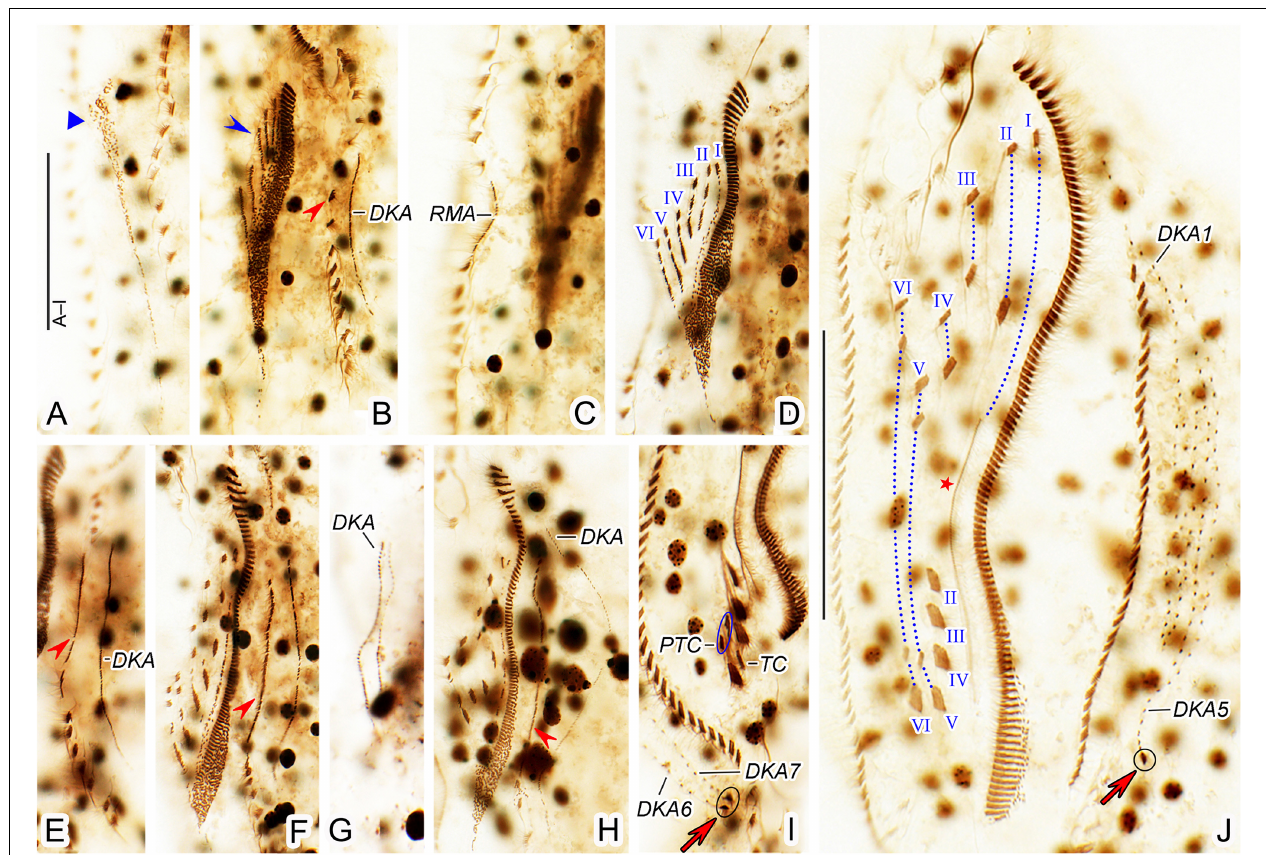
FIGURE 5 | Trachelostyla multinucleata spec. nov., early (A–C) , middle (D–H), and late (I,J) stages of physiological reorganization after protargol impregnation. (A–C) Ventral views to show the formation of the oral primordium (blue triangle), frontal-ventral-transverse cirral anlagen (blue arrowhead), left (red arrowhead) and right marginal cirral anlagen. (D–H) Ventral views, showing the formation of left (red arrowheads) marginal cirral anlage and dorsal kineties anlagen. Frontal-ventral-transverse cirral anlagen are numbered from left to right with I–VI. (I) Detailed ventral view, red arrow marks two caudal cirri. (J) Ventral view of another late reorganizer to show the left caudal cirrus (red arrow), undulating membranes anlage (red asterisk), and dorsal kinety anlagen. Frontal-ventral-transverse cirri originating from the same anlagen are connected by red dotted lines and numbered from left to right with I–VI. DKA1, 5, 6, 7, the first, fifth, sixth, and seventh dorsal kinety anlage; PTC, pretransverse ventral cirri; RMA, right marginal cirral anlage; TC, transverse cirri; I–VI, frontal-ventral-transverse cirri originating from anlagen I–VI. Scale bars = 50 µ